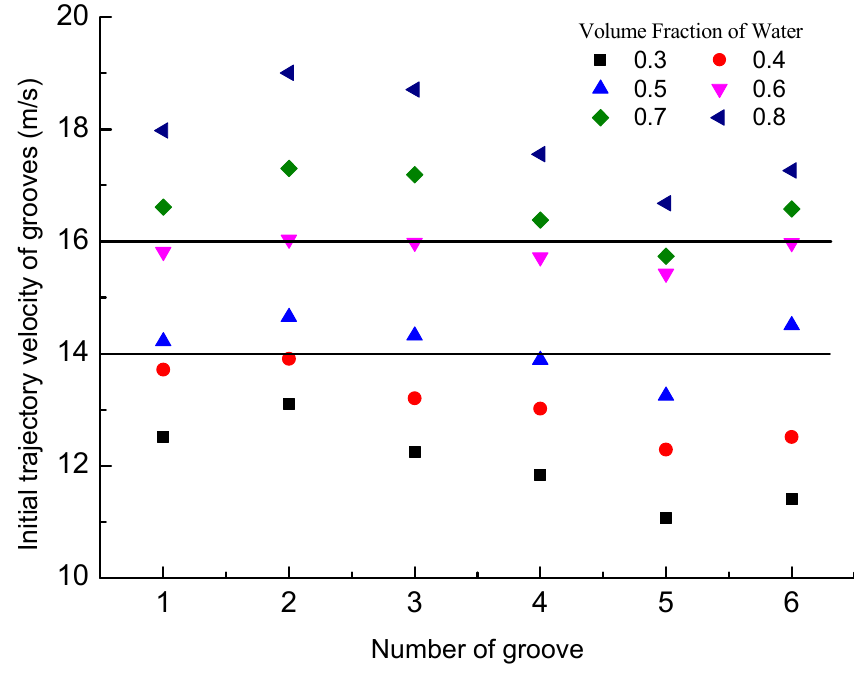
Figure 4. Calculated velocity with different volume fractions of water.